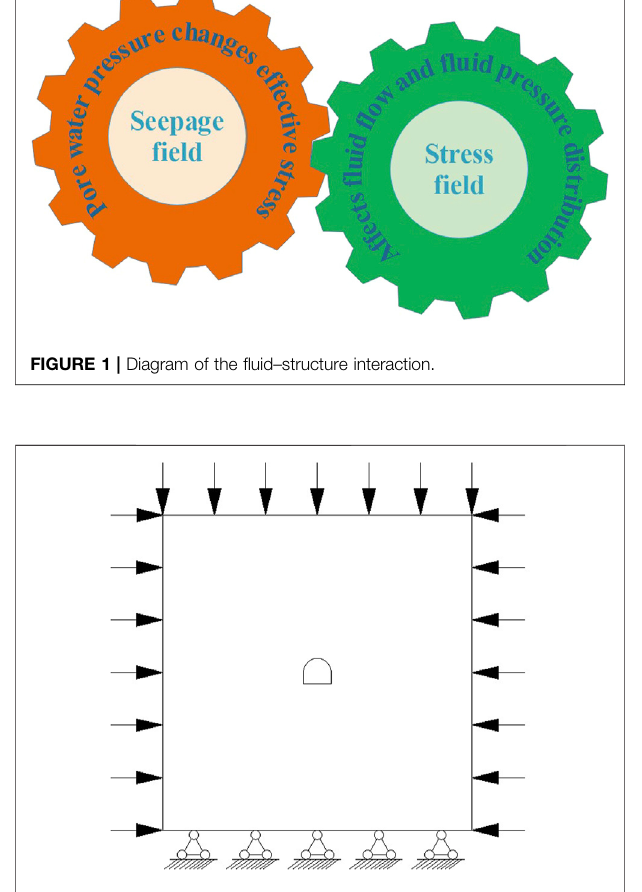
FIGURE 2 | Boundary conditions.